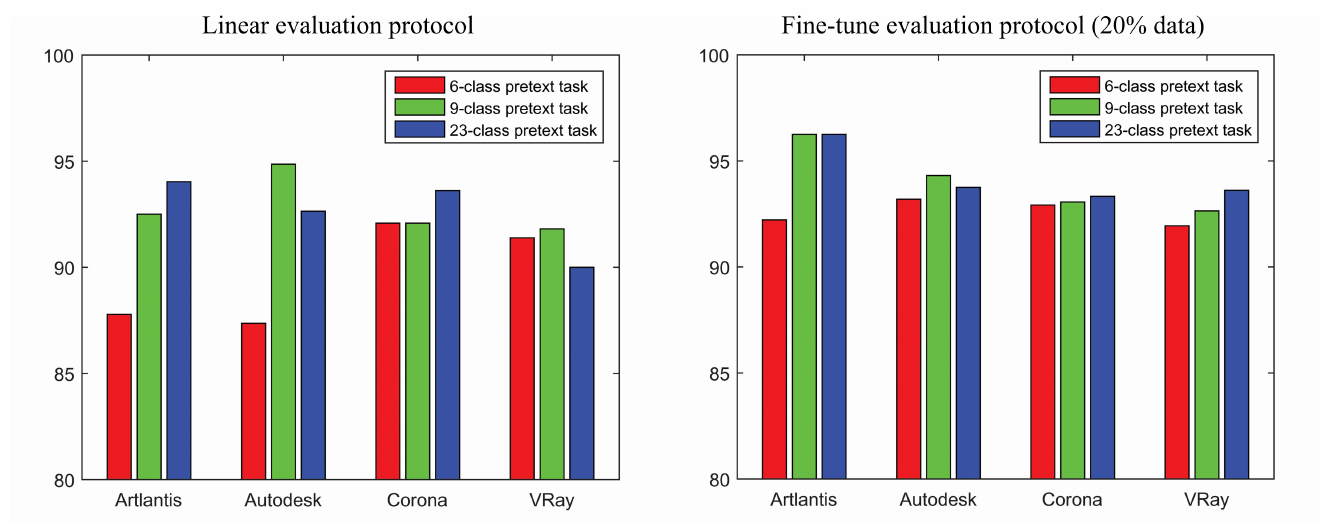
Figure 5. Comparisons of CG forensics performances of different versions of self-supervised pretext tasks, respectively, with 6 classes, 9 classes and 23 classes ( cf. the main text for details). The comparisons were carried out on the four CG forensics datasets of Artlantis, Autodesk, Corona and VRay, under the linear evaluation protocol (left panel) and the fine-tune evaluation protocol (right panel). The vertical axes in the two panels represent the classification accuracy (in percentage) on testing set. The results in the two panels were not directly comparable, because the amount of training samples was different (whole training set for the left panel and 20% training data for the right